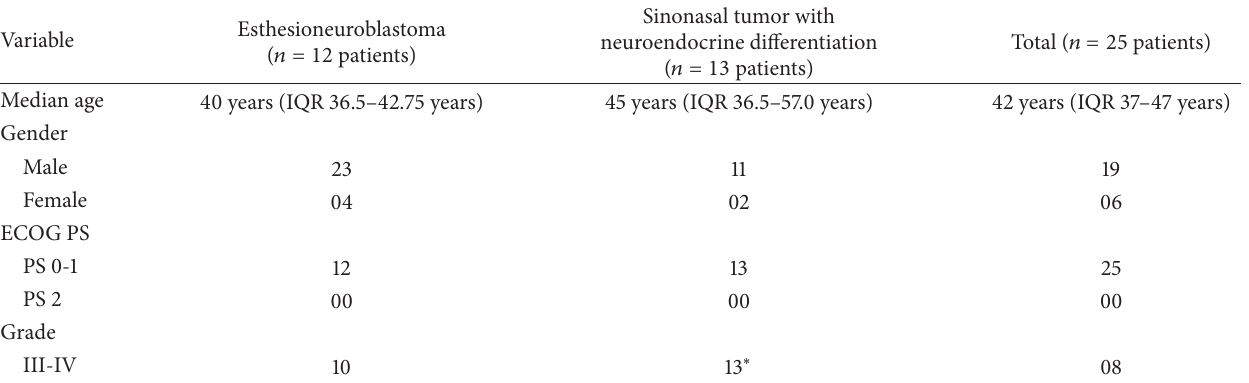
Table 1: Baseline details according to histological subtypes.